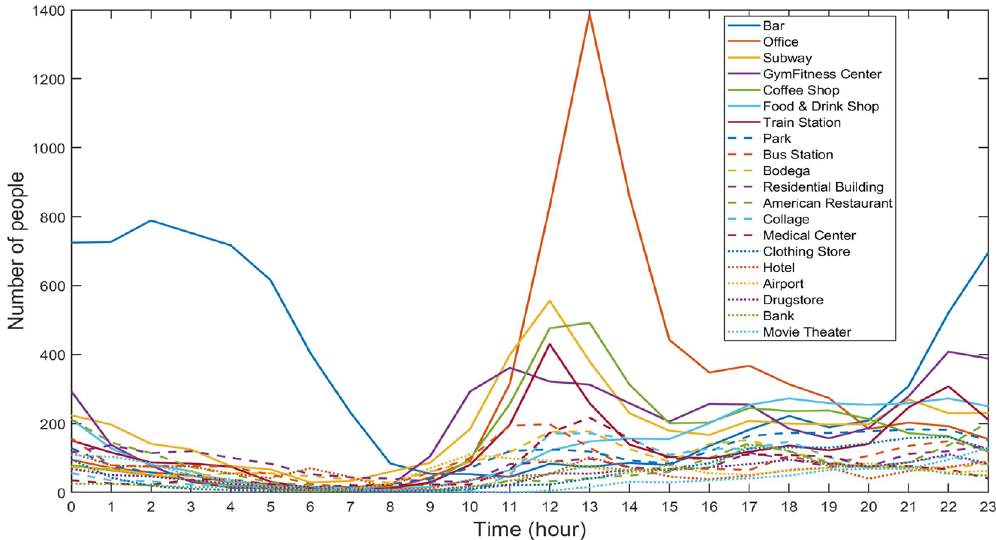
Figure 6. Temporal statistical properties of location semantics in the experimental